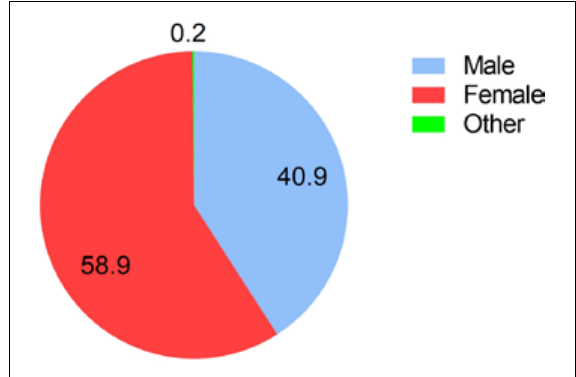
Figure 2. Gender distribution of respondents (percent).